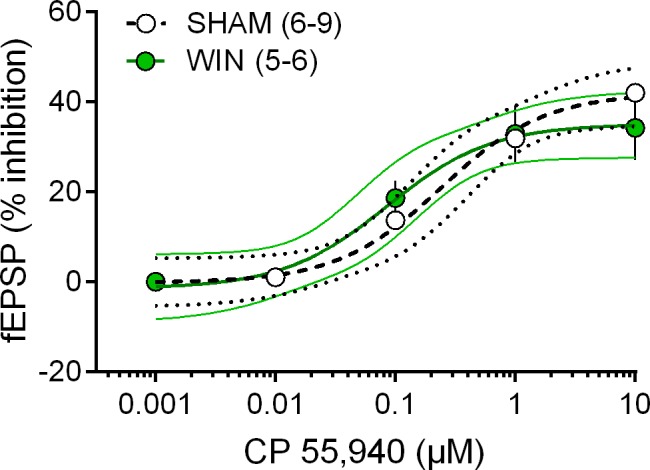
Prenatal cannabinoid exposure does not modify synaptic CB1R potency or efficiency.Dose-response curve for the cannabimimetic CP55,940 in SHAM (white symbols, n = 6–9 animals, EC50 = 0.240 μM, top value 42.01%, 95% CI for EC50 = 0.088–0.658) and WIN-exposed (green symbols, n = 5–6, EC50 = 0.085 μM, top value 35.09%, 95% CI for EC50 = 0.025–0.292) male rats. fEPSP amplitudes were measured 30 min after application of CP55,940. Each point is expressed as the percentage of inhibition of its basal value. Error bars indicate SEM.